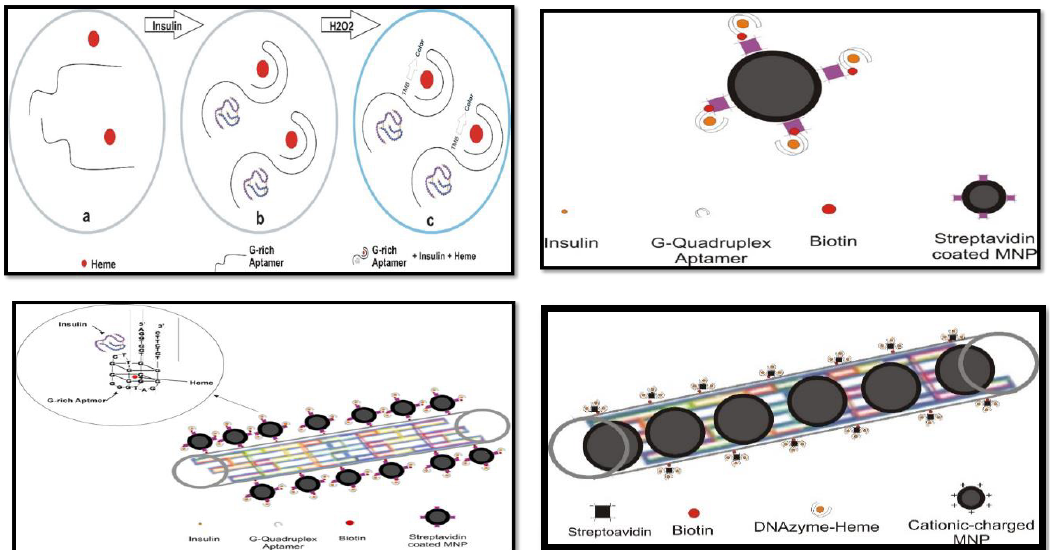
Fig. 10. Graphical abstract of conjugated and non-conjugated Insulin